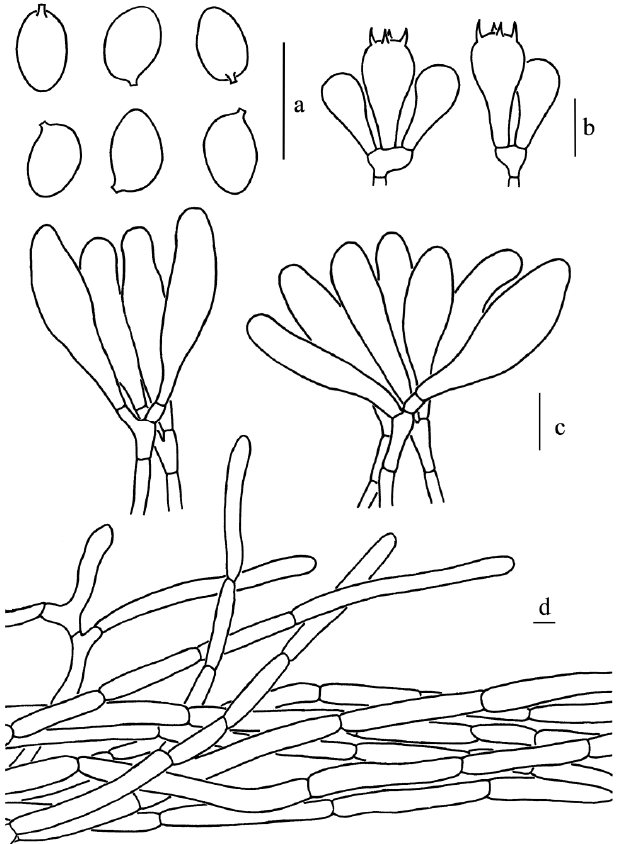
Figure 9. Leucoagaricus candidus (CFSZ 20964). ( a ) Basidiospores. ( b ) Basidia. ( c ) Cheilocystidia. ( d ) Elements of pileus surface. Scale bars: 10 μm. Diagnosis: Leucoagaricus candidus is characterized by its white basidiomata, white pi- leus squamules, a margin often with appendiculate white veil remnants and ellipsoid to broadly ellipsoid basidiospores.